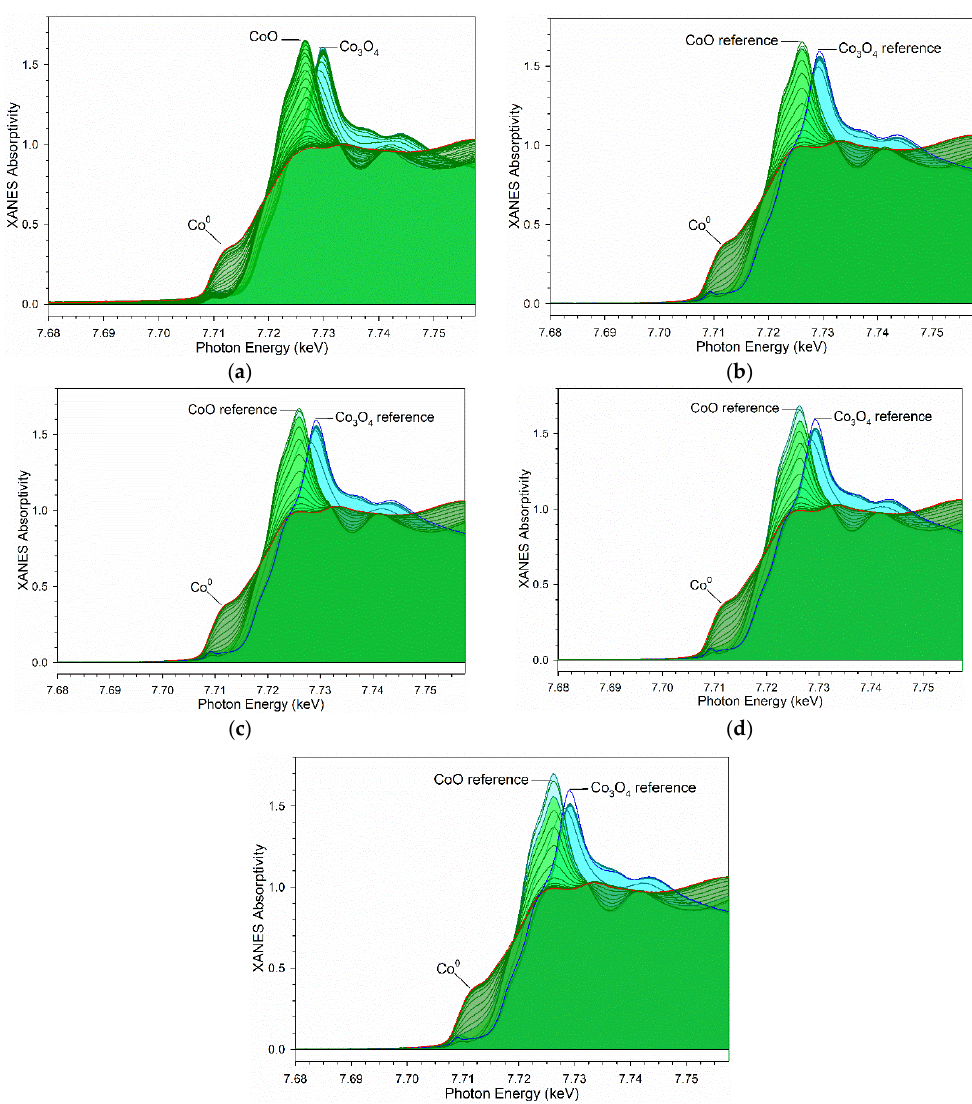
Figure 5. H 2 -TPR-XANES spectra (XY view) at the Co K-edge of ( a ) 25%Co/Al 2 O 3 , ( b ) 25%M (M = 5%Ni-95%Co)/Al 2 O 3 , ( c ) 25%M (M = 10%Ni-90%Co)/Al 2 O 3 , ( d ) 25%M (M = 25%Ni-75%Co)/Al 2 O 3 , and ( e ) 25%M (M = 50%Ni-50%Co)/Al 2 O 3 .